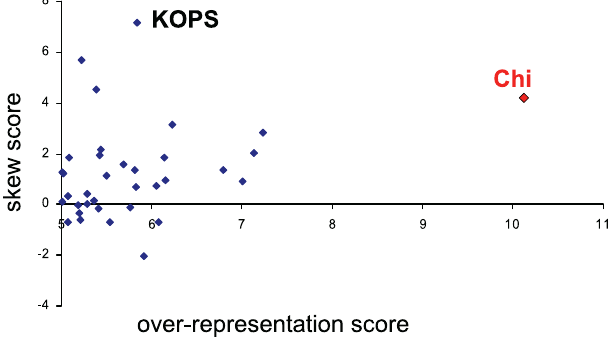
Figure 1. The E. coli Chi site, 5 9 -GCTGGTGG-3 9 , Is Significantly Overrepresented and Skewed on E. coli Backbone DNA Statistical scores of overrepresentation and skew are plotted for all octamers whose overrepresentation scores are higher than 5 (corre- sponding to a p -value , 10 (cid:2) 7 ). Chi and one of the motifs of the KOPS family [6] are indicated.